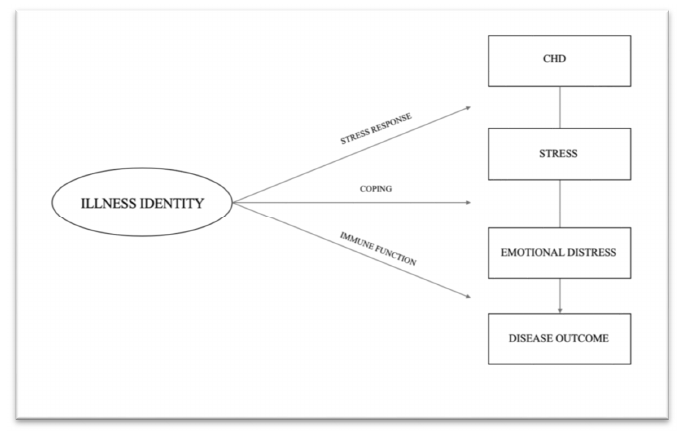
Figure 1. Hypothetical Pathways by Which Illness Identity Influences Emotional Distress and Disease Outcome; Derived and Modified According to Carver and Vargas [12].